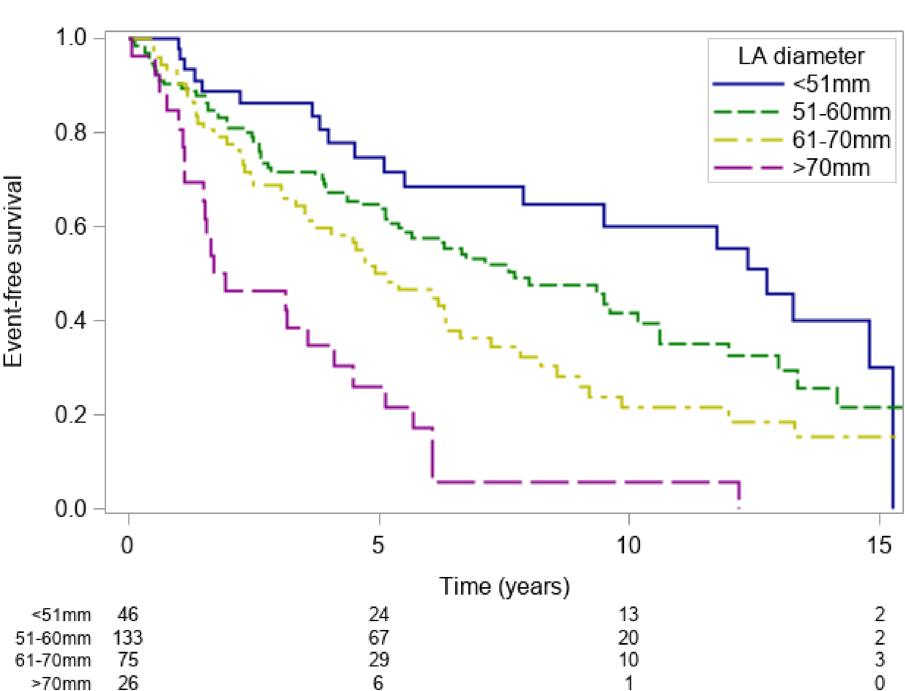
Figure 1. Kaplan–Meier event-free survival estimates for patients with LA diameter < 50 mm (blue line), 50-60 mm (green line), 60-70 mm (yellow line) and ≥ 70 mm (violet line). LA left